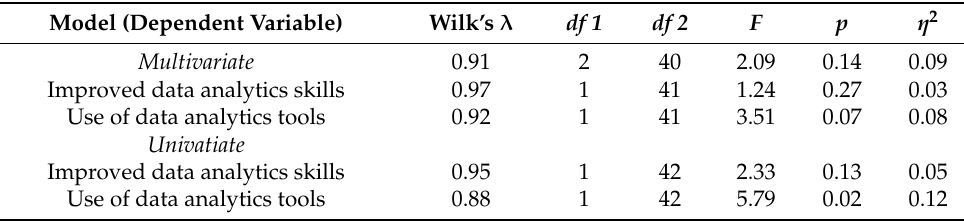
Table 2. Results of multivariate and univariate analysis of covariance.